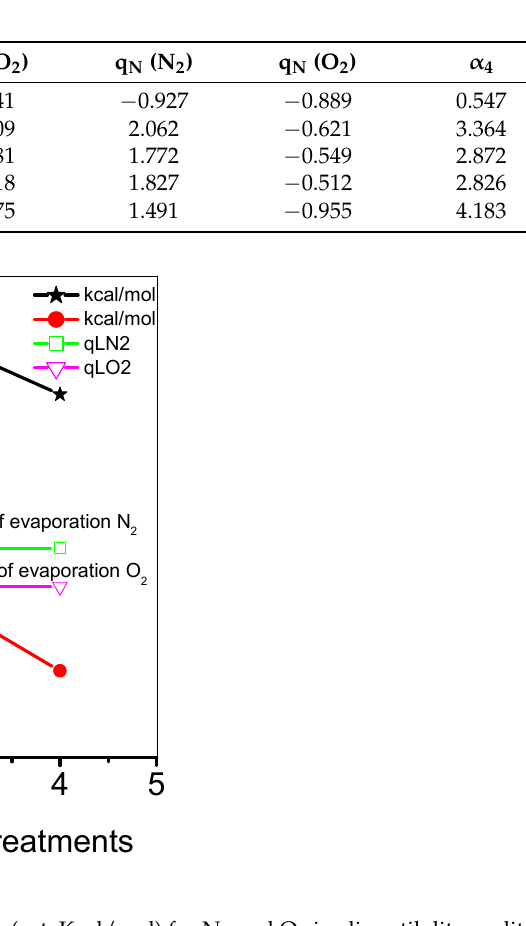
2 and O 2 in clinoptilolite